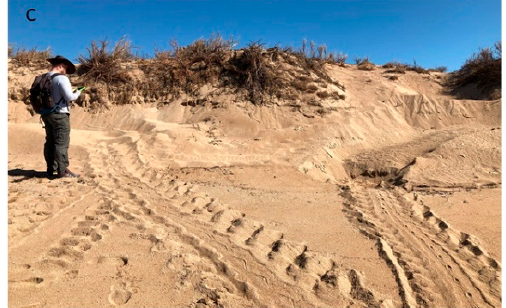
Figure 2. ( a ) Example of an aerial photograph of a new flatback turtle track with a successful nest. The most recent high-tide line is highlighted as well as the up and down portions of the track. ( b ) Example of an aerial photograph of new green turtle tracks. A green turtle (white arrow) is leaving the beach after nesting. ( c ) Staff recording a flatback turtle (left) and a green turtle (right) tracks during a morning monitoring survey on Thevenard Island. The green turtle nest is also visible.